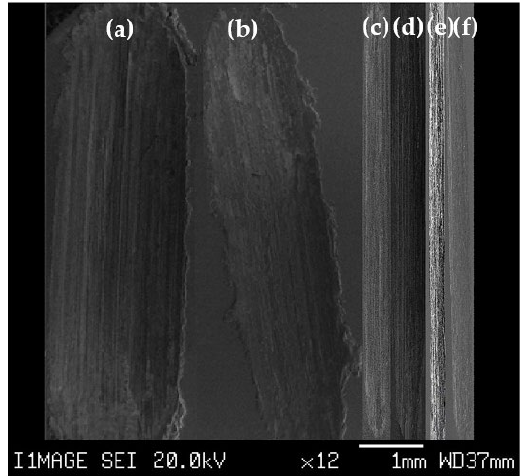
Figure 1. Photomicrographs of the wear scars of ( a ) PM Al, ( b ) HPT-processed Al, ( c ) PM Al-20% SiC, ( d ) PM Al-20% Al 2 O 3 , ( e ) HPT-processed Al-20% SiC, and ( f ) HPT-processed Al-20% Al 2 O 3 samples tested under a sliding distance of 1260 m and an applied load of 20 N.